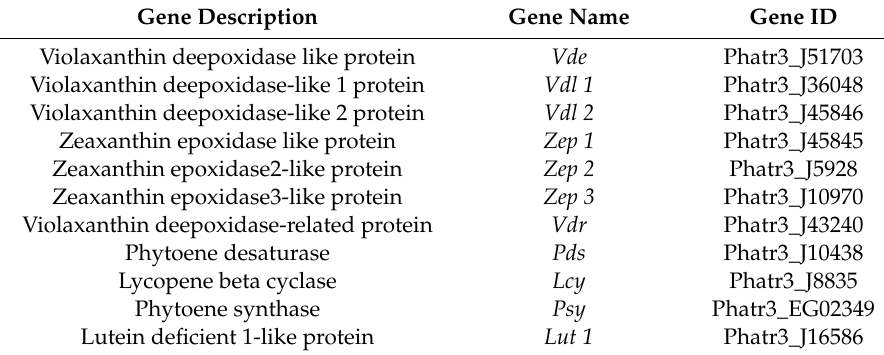
Table 1. Genes selected for overexpression vectors